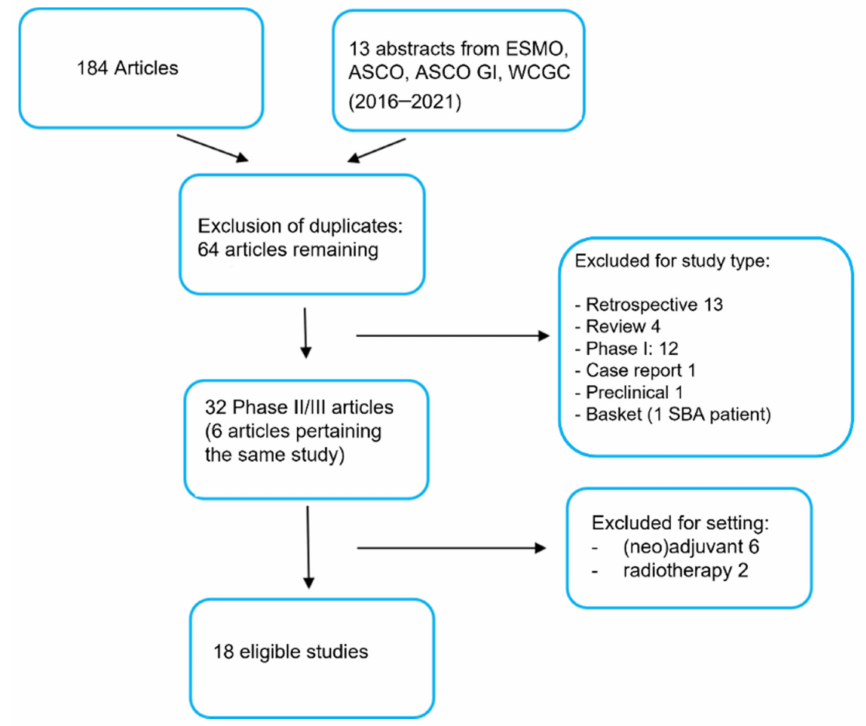
Figure 1. PRISMA chart. Description of the process of selection of the studies analyzed for the systematic review. The selected keywords generated a first list of full studies and abstract (197). Then, inclusion and exclusion criteria were applied. Finally, eighteen studies were selected, tabulated and analyzed for the final